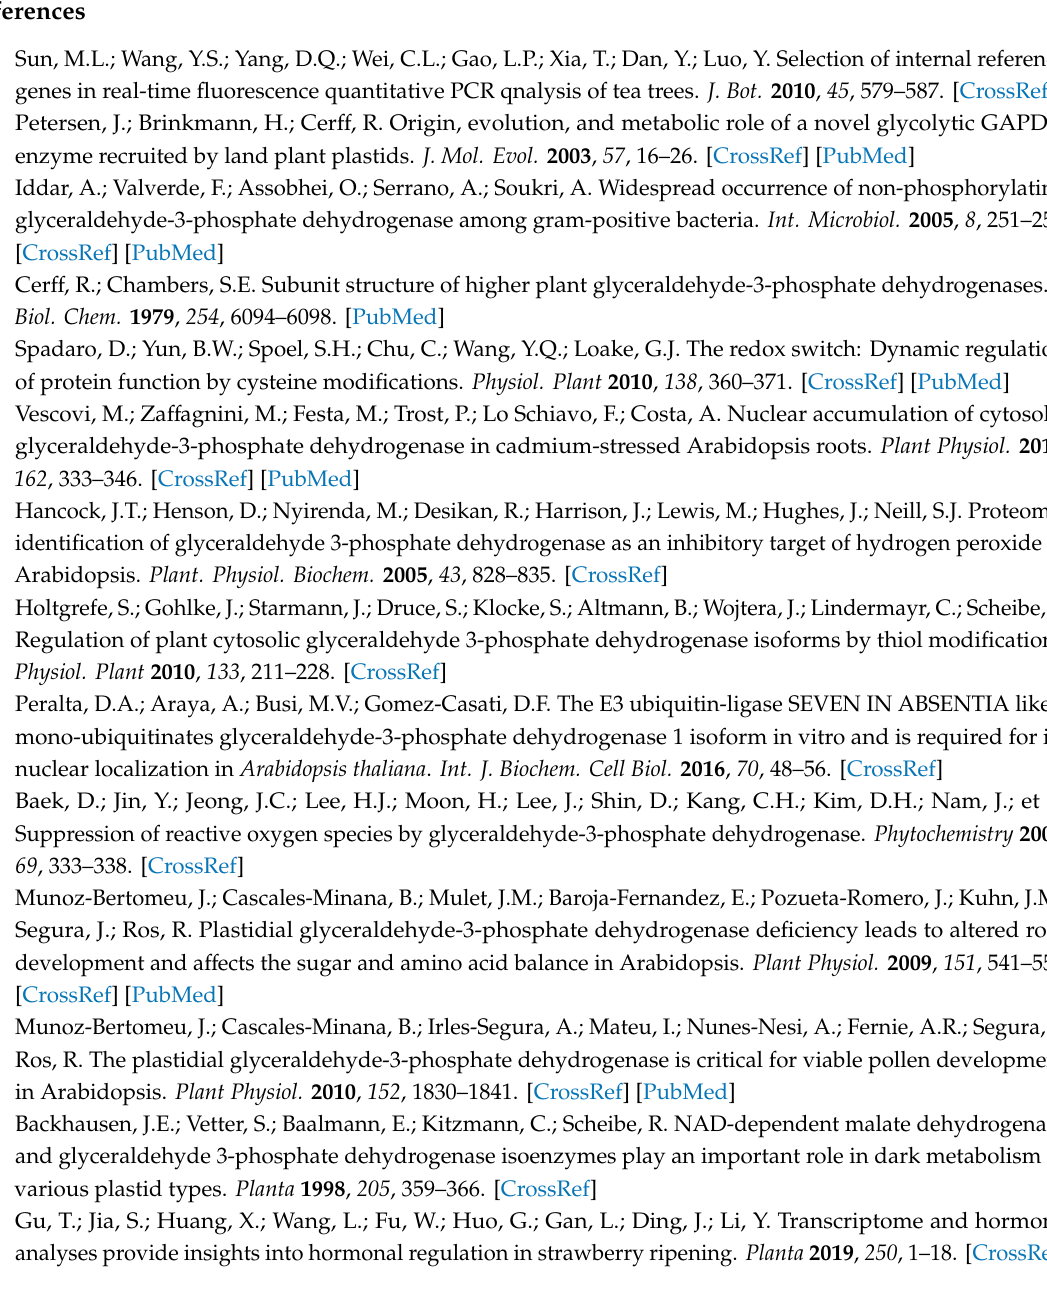
Figure S1: title, Table S1: title, Video S1: title.Table S1. Primers used for cloning in this study. Table S2. Primers used for plasmid construction in this study. Table S3. Primers used for real-time PCR in this study. Table